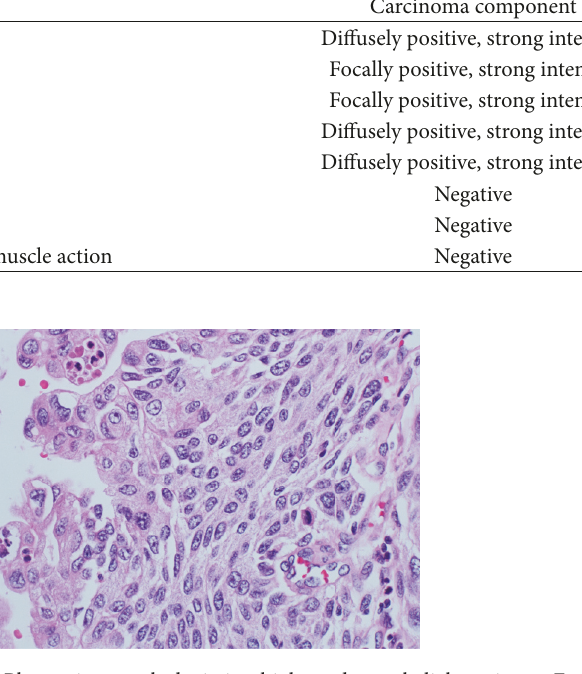
Figure 5: Photomicrograph depicting high grade urothelial carci- noma with transformation to sarcomatoid carcinoma characterized by a spindle cell pattern.